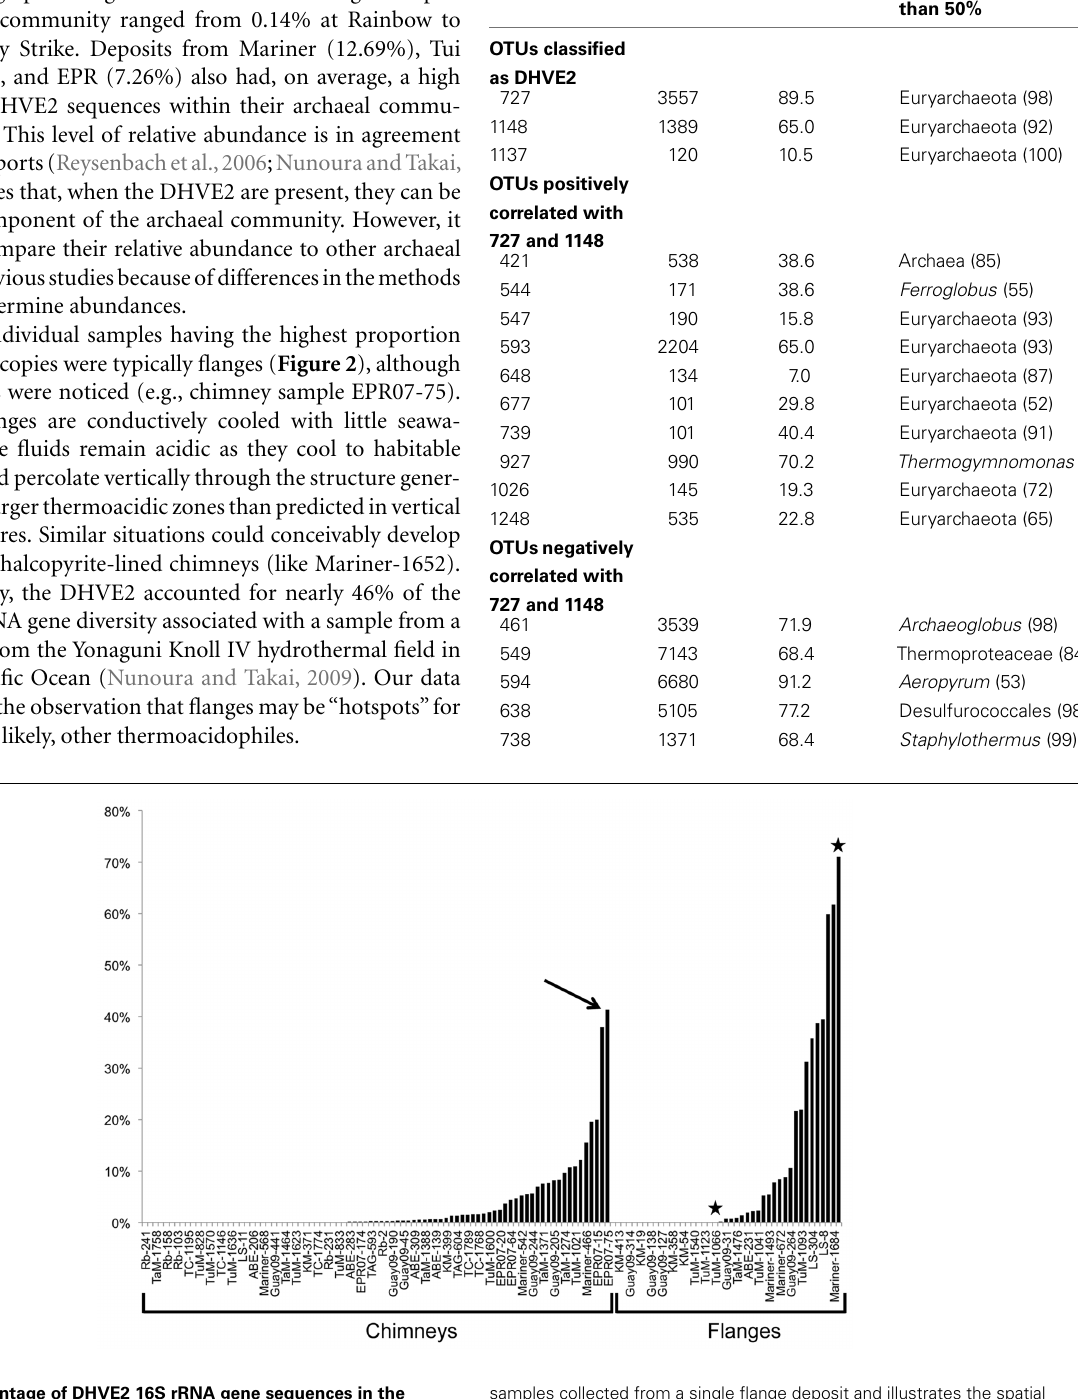
samples collected from a single flange deposit and illustrates the spatial heterogeneity of the DHVE2. Abbreviations are: Rb, Rainbow;TaM,Tahi Moana;TC,Tow Cam;TuM,Tui Malila; LS, Lucky Strike; Guay09, Guaymas (cid:2) indicates two Basin 2009; KM, Kilo Moana; EPR07, East Pacific Rise